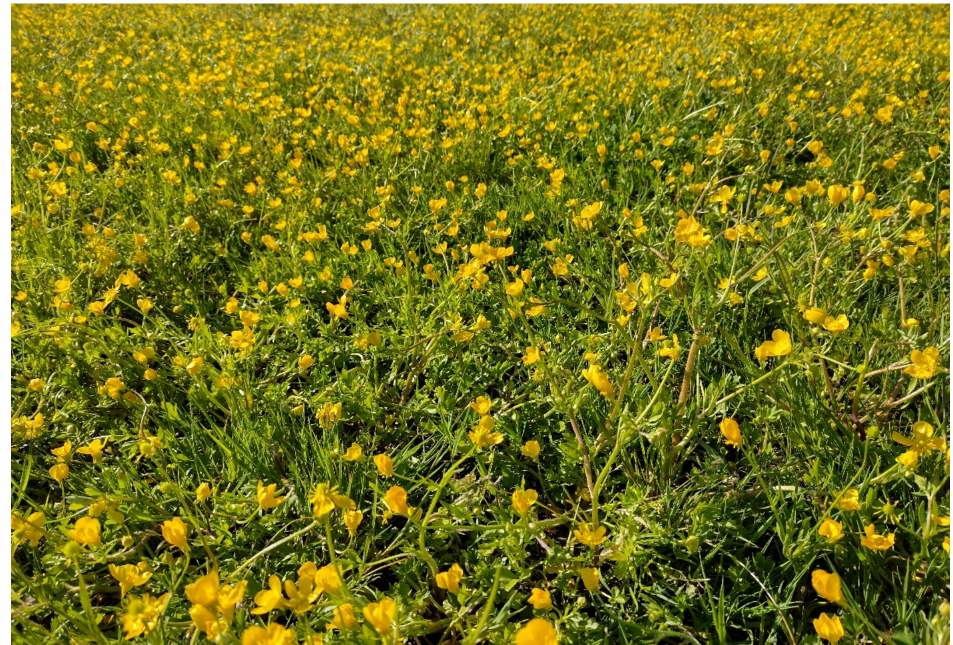
Figure 82. Humid meadow dominated by Ranunculus repens L. (Caffarella